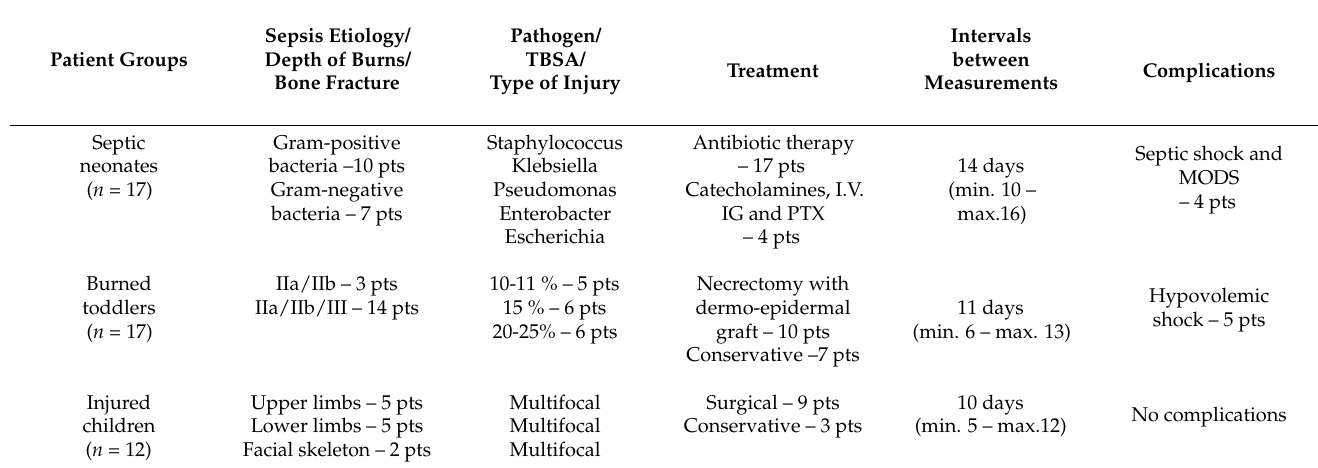
Table 2. The characteristics of systemic inflammatory response syndrome (SIRS) patients (septic/burned/injured children).